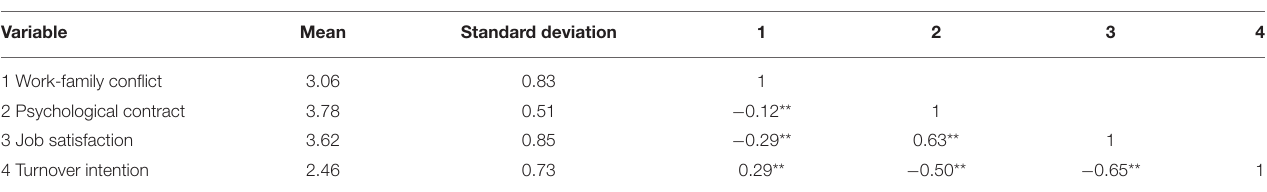
TABLE 3 | Mean, standard deviation, and correlation analysis results of each